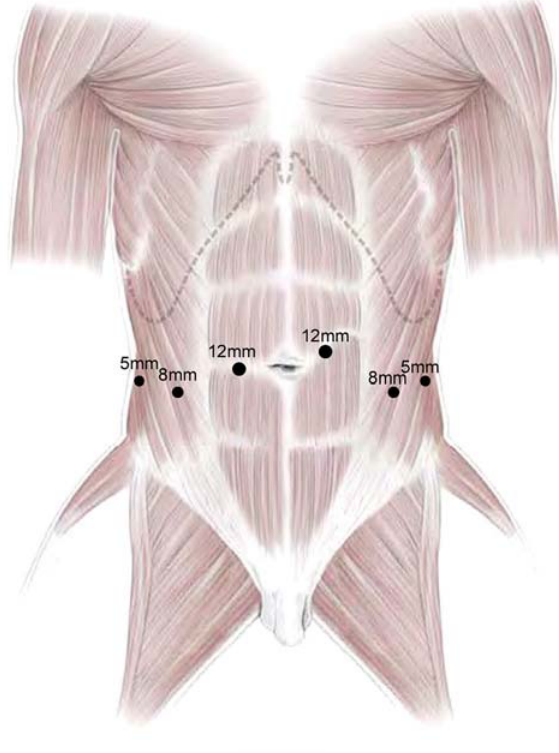
Figure 2 – Port placement during robotic assisted laparoscopic radical